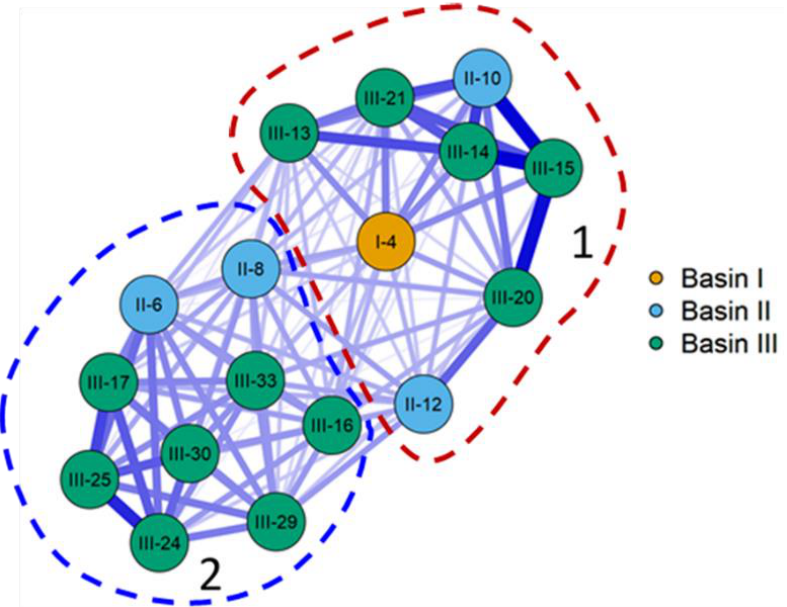
Figure 5. JASP correlation networks plot for diversity of indicator species in the communities of the studied sites of South and Southeast Kazakhstan, 2019 – 2022. Cluster 1, red outline, lowland sites, Cluster 2, blue outline, highland sites.